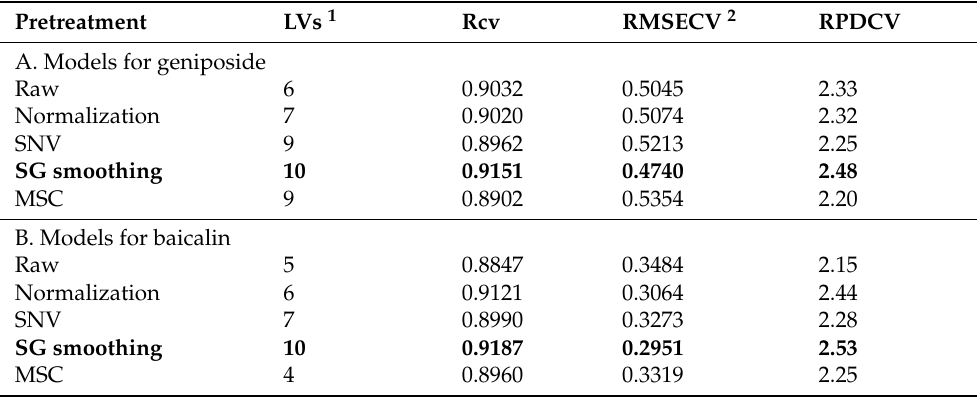
Table 2. Performance of different spectral pretreatments models for 2 Table 1. Reference values for geniposide and baicalin of the data sets.